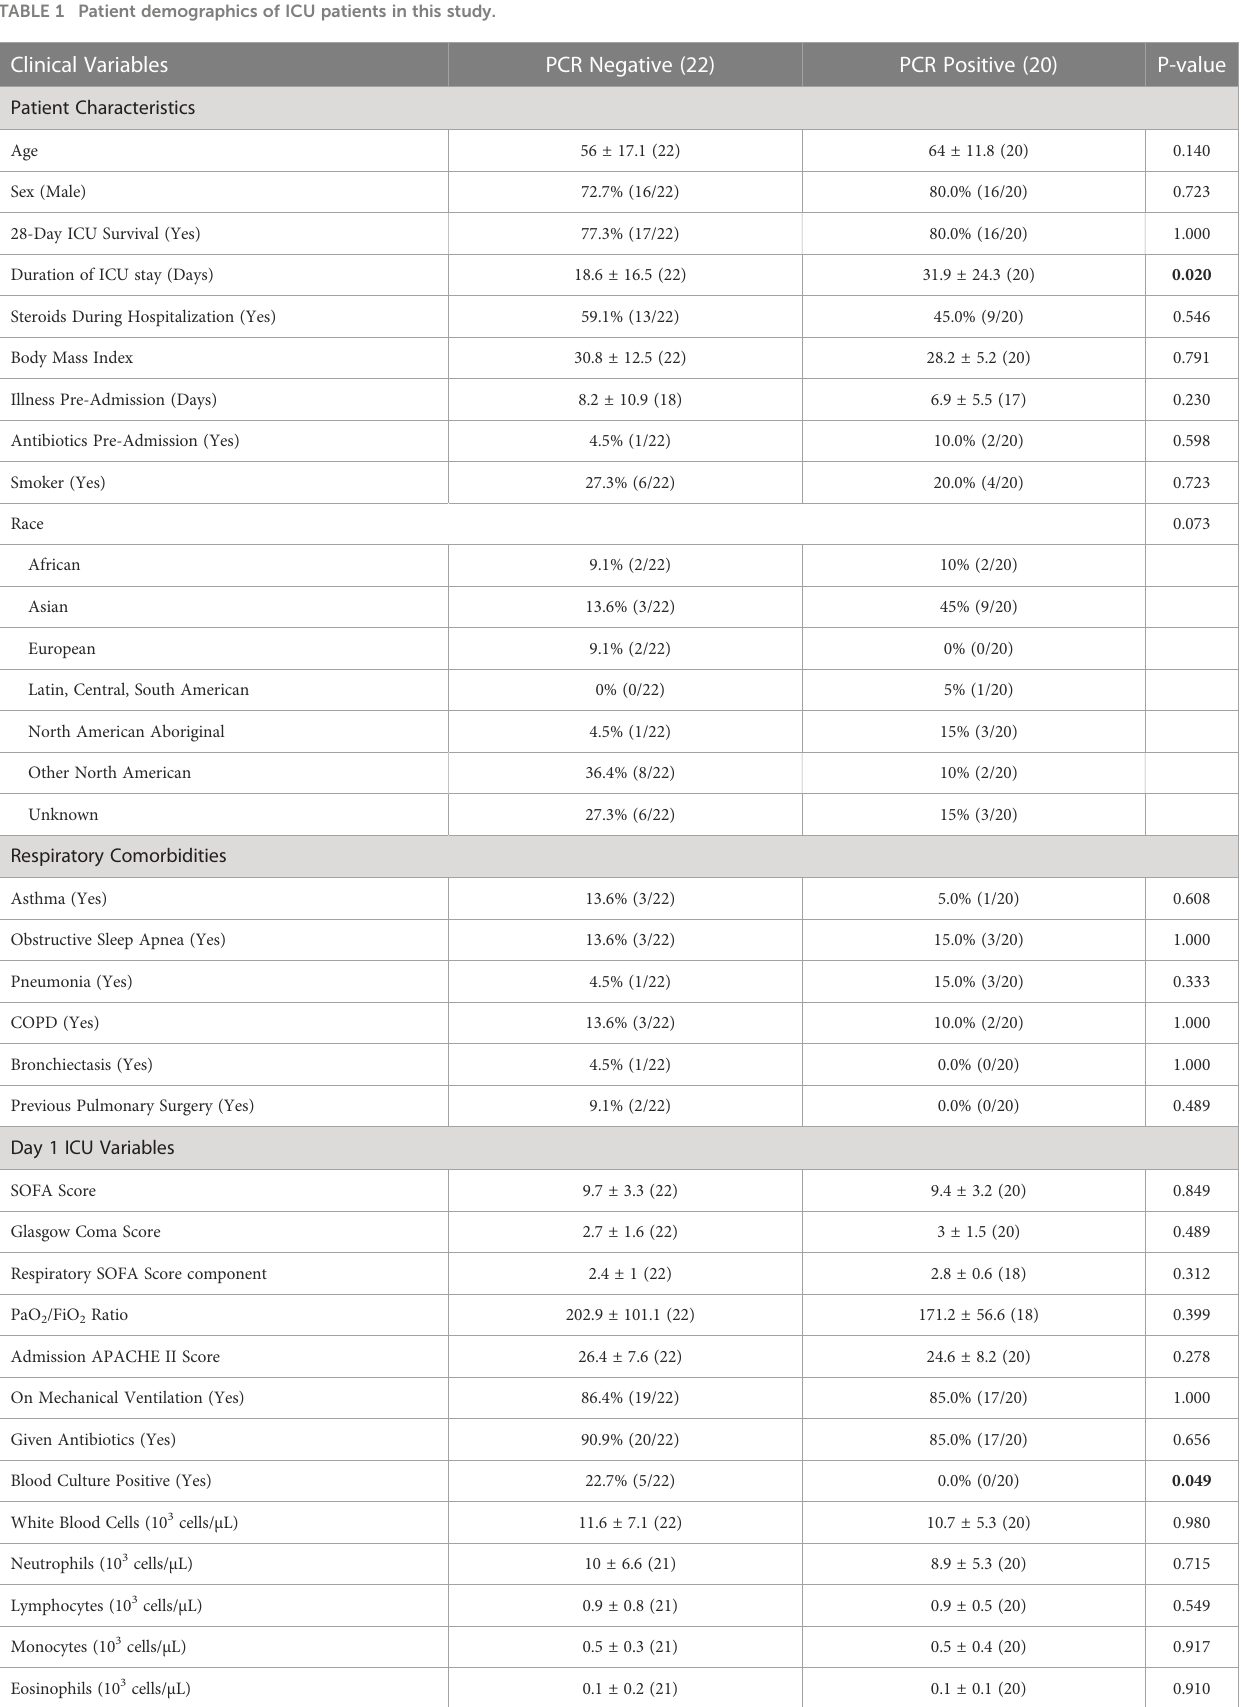
TABLE 1 Patient demographics of ICU patients in this